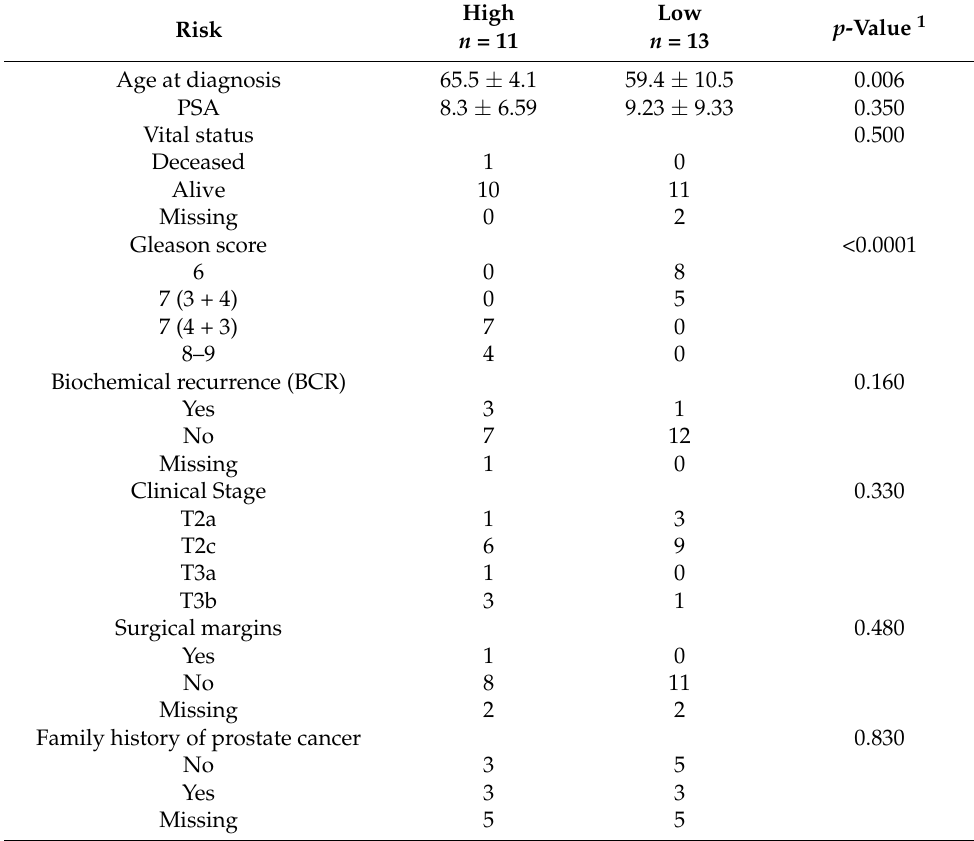
Table 1. Clinicopathological characteristics of Puerto Rican men with aggressive (high-risk) ( n = 11) and indolent (low-risk) ( n = 13) prostate cancer in the study group.